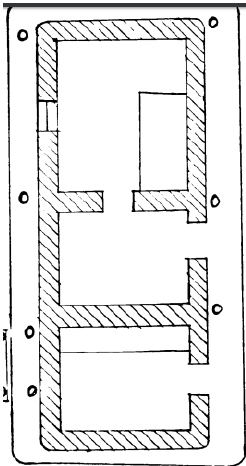
Figure 13 i. Plan of a Family Unit, Source. (Nsude, 1987)